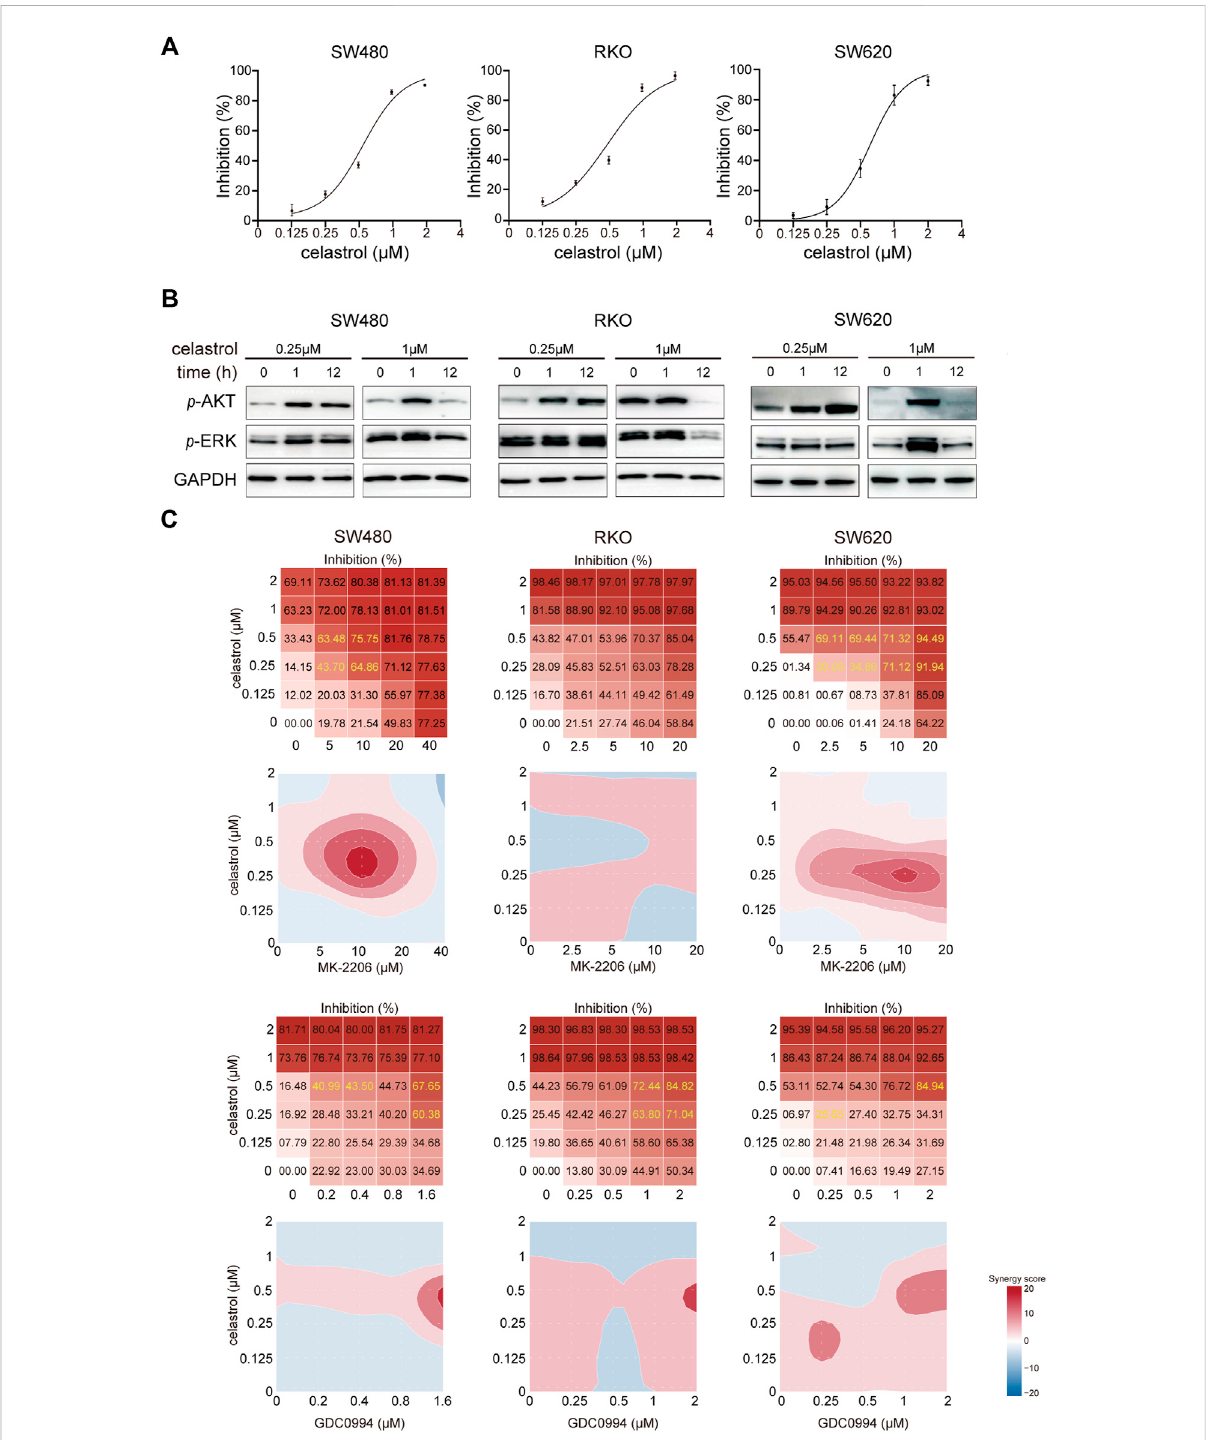
FIGURE 1 Low-dose celastrol treatment results in sustained AKT/ERK activation in CRC cells. (A) Growth inhibition curves of CRC cells in response to celastroltreatmentwithdifferentdoses. (B) Expression of p -AKTand p -ERKinCRC cellsreceivedcelastroltreatmentwith0.25 and1 µMfor0,1,and 12 h. (C) Inhibitory effect and synergy score of combined treatment of AKT/ERK inhibitor with celastrol in CRC